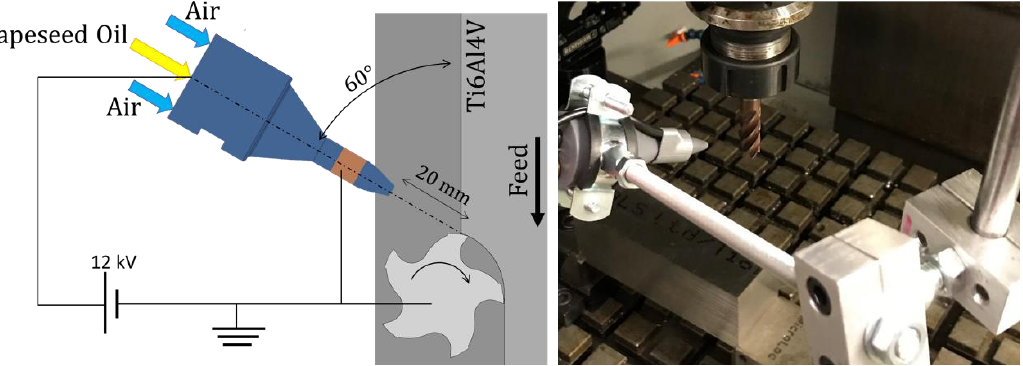
Figure 3. EHDA-MQL setup for milling experiments (electrical insulation is removed from the nozzle to show the setup).